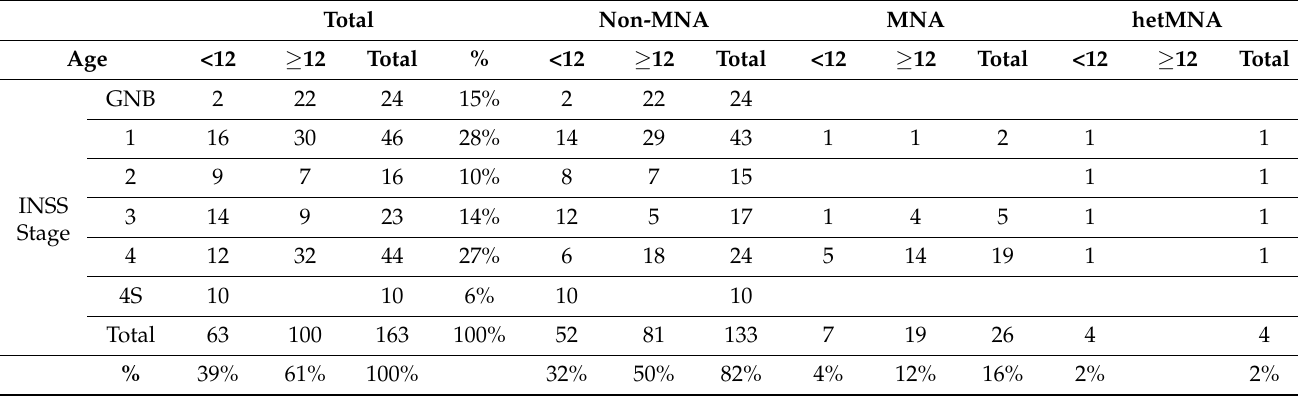
Table 2. Characteristics of the A-NB94 study